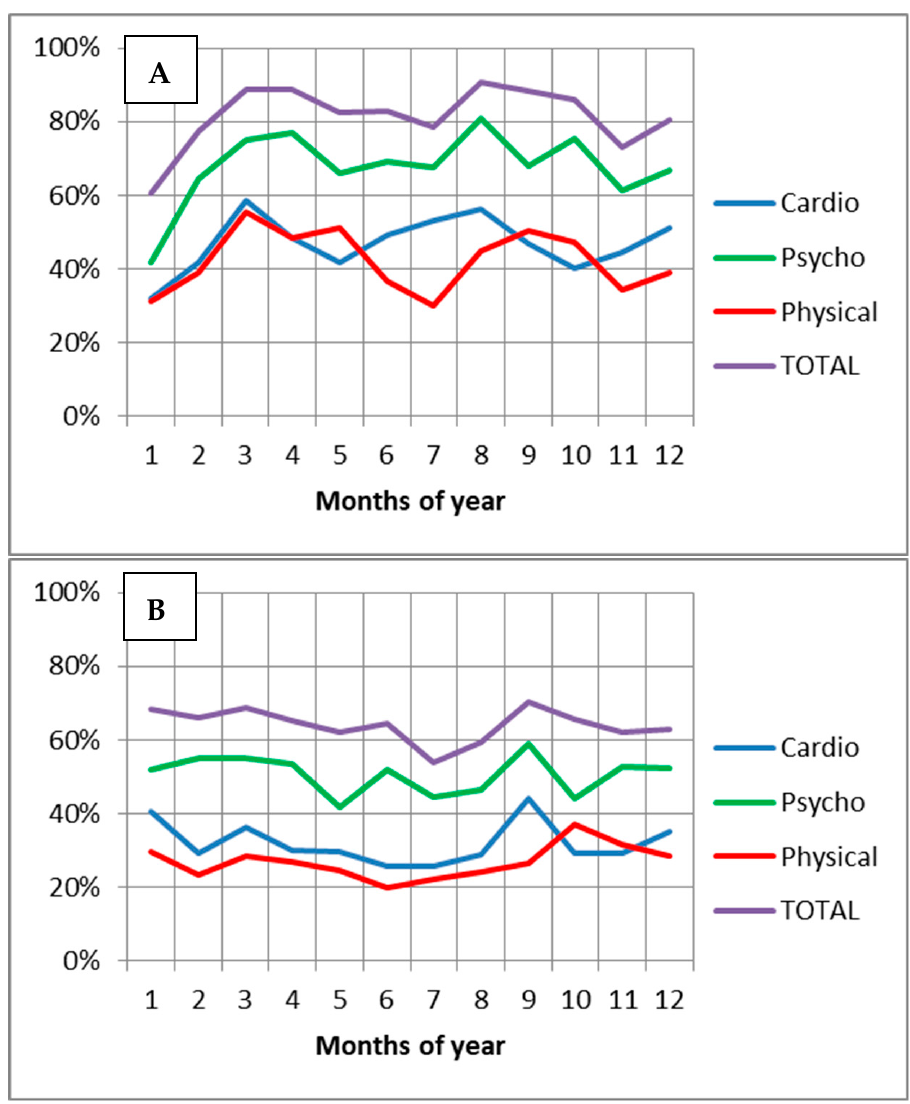
Figure 3. Percentages of measurements per month, of patients with CAD who reported one or more subjective well-being symptoms on the PSAD-WS total scale and symptom subscales: ( A ) Weather sensitive patients; ( B ) not weather sensitive patients. Seasonal Associations between Subjective Well-Being and Weather Parameters: Multivariate Approach (among WS Patients)